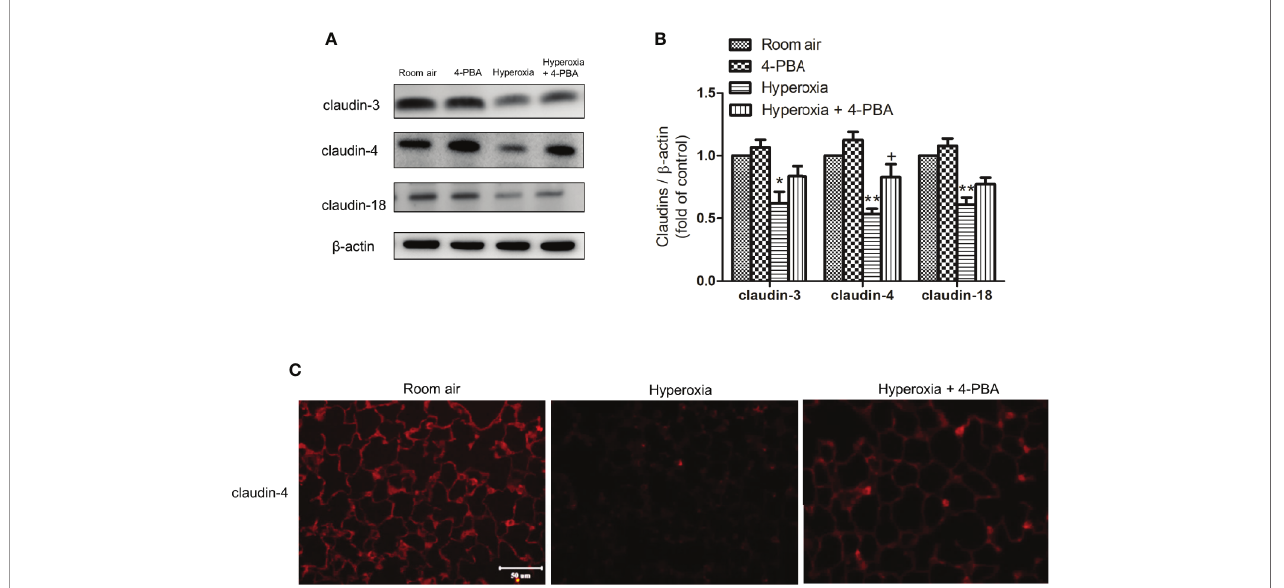
FIGURE 6 | 4-PBA enhances claudin-4 protein expression in mice with HALI. (A) Western blot analysis of claudin-3, claudin-4, and claudin-18 expression in lung tissues. (B) Relative expressions of claudins in lung tissues were shown. (C) Representative immuno fl uorescence staining of claudin-4 (red fl uorescence). The results are expressed as the mean ± SD; n= 3. *p < 0.05 and **p < 0.01, compared with the room air group, + p < 0.05 compared with the hyperoxia group.